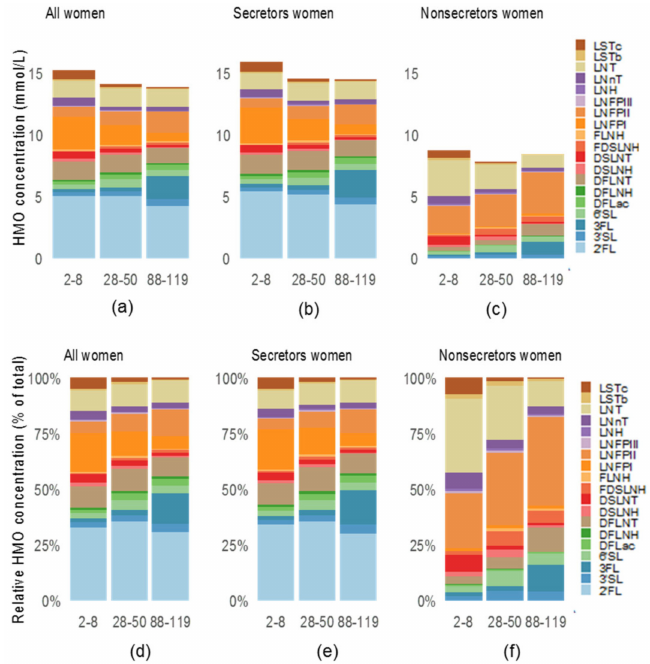
Figure 2. HMO absolute and relative abundance of women from the Brazilian cohort. Rio de Janeiro, Brazil. Median of absolute total HMO (mmol / L) ( a – c ) at 2–8, 28–50 and 88–119 days and relative abundance ( d – f ) at 2–8, 28–50 and 88–119 days concentrations of all women, according secretor status and follow-up points. DFLac, difucosyllactose; DFLNH, difucosyllacto-N-hexaose; DFLNT, difucosyllacto-N-tetrose; DSLNH, disialyllacto-N-hexaose; DSLNT, disialyllacto-Ntetraose; FDSLNH, fucodisialyllacto-N-hexaose; FLNH, fucosyllacto-N-hexaose; HMO, human milk oligosaccharide; LNFP, lacto-N-fucopentaose; LNH, lacto-N-hexaose; LNnT, lacto-N-neotetraose; LNT, lacto-N-tetrose; LSTb, sialyl-lacto-N-tetraose b; LSTc, sialyl-lacto-N-tetraose c; 2 (cid:48) FL, 2 (cid:48) -fucosyllactose; 3FL, 3-fucosyllactose; 3 (cid:48) SL, 3 (cid:48) -sialyllactose; 6 (cid:48) SL, 6 (cid:48) -sialyllactose. Significant di ff erences in HMO concentrations between secretor and non-secretor women ( p ≤ 0.05) (cid:48) were observed for almost all HMOs except 6 -SL, DSLNH, DSLNT, FLNH, LNFPIII, LNH and LNnT (cid:48) at one or more visits. Among secretor women, the HMOs 3FL (2.24 mmol / L), 3 SL (0.56 mmol / L), DFLac (0.45 mmol / L) and LNFP II (1.55 mmol / L) presented higher values at 88–119 days in comparison with other visits (Figure